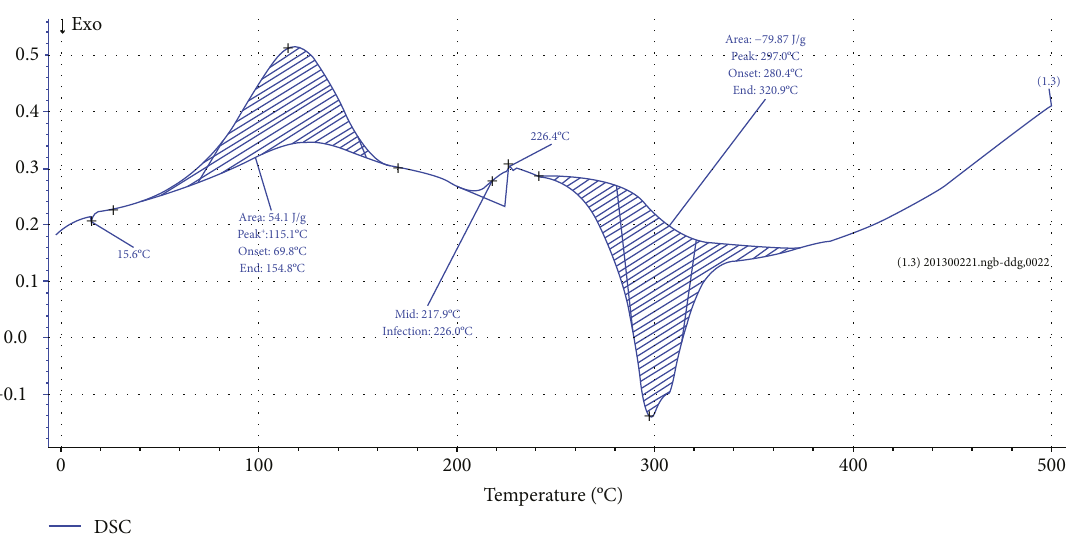
Figure 4: DSC curves for GAP in an inert